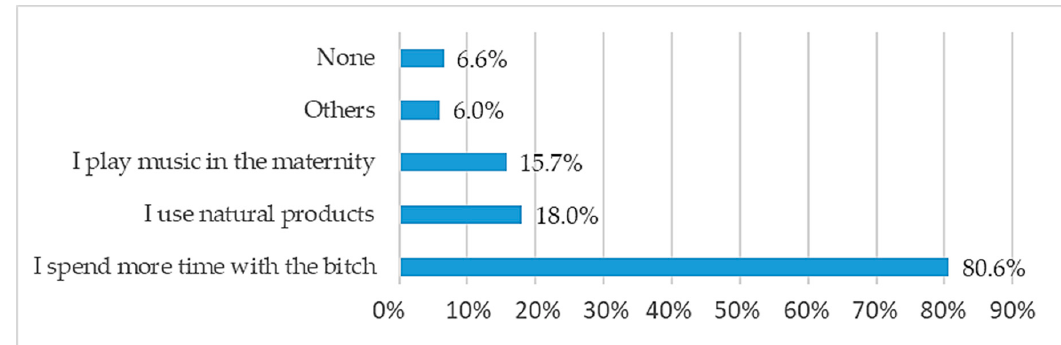
Figure 10. Ways to reduce stress in the bitch during parturition (multiple answers allowed).